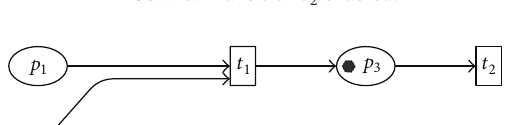
Figure 3: Transition 𝑡 2 enabled.